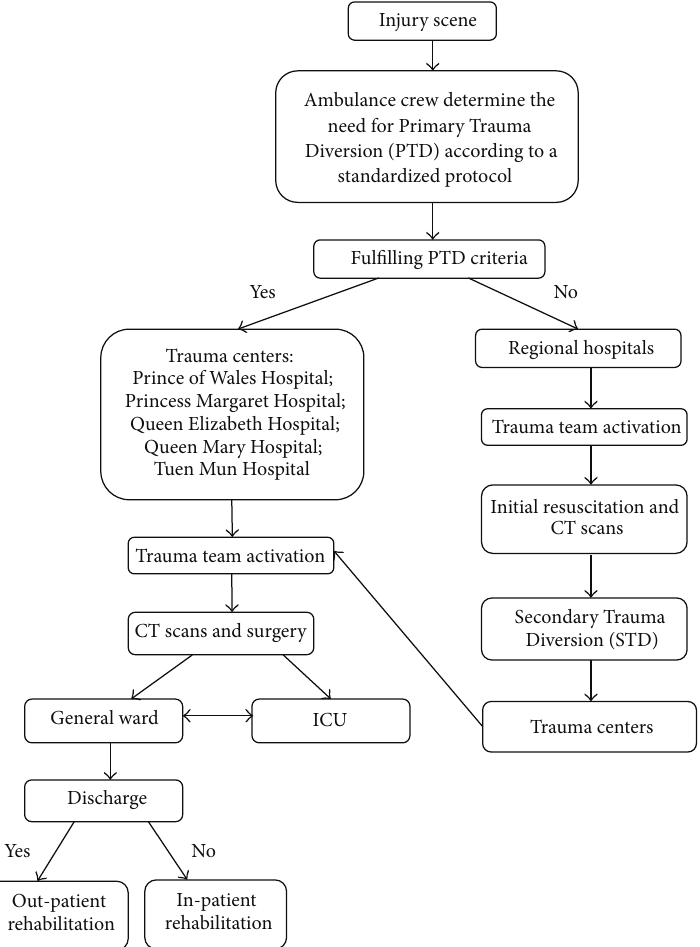
Figure 1: Flow diagram illustrating trauma patient